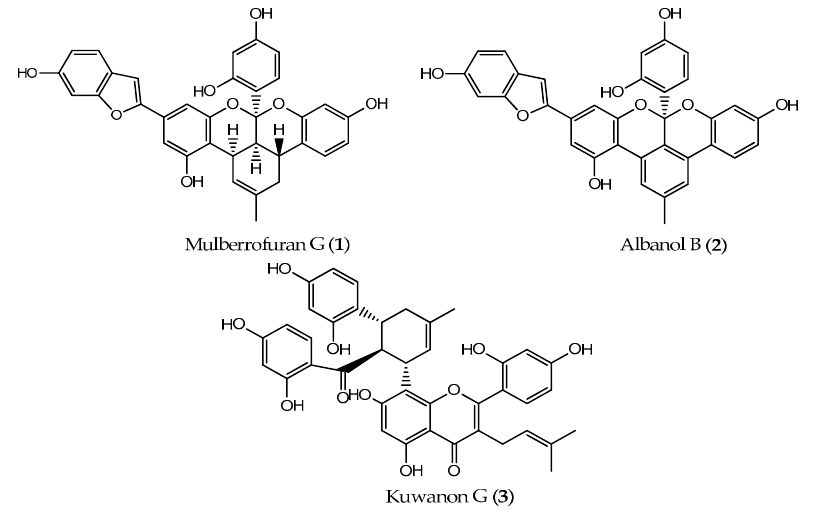
Figure 1. Structures of the isolated compounds from the root bark of Morus alba L. Table 1. Protein tyrosine phosphatase 1B and α -glucosidase inhibitory activity of the compounds isolated from M. alba .